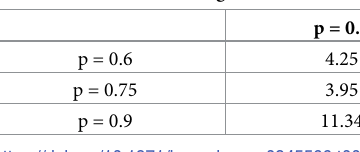
To confirm our findings, we further analyzed the data by considering the share of high- quality decisions of her high/low quality decisions (i.e., we interpreted our categorical variable as the percentage of each participant choosing high quality). Based on the data for each group of two participants in parts 1 and 2 of our experiment, we used the Jonckheere-Terpstra test [45, 46] to assess whether a trend in the data is apparent. Since we presume that effects needed some rounds to level off, we used the data from rounds 13–24 (part 1) and 37–48 (part 2) for this assessment. The result shows a trend with significance for part 1 (p < 0.10, n = 24, df = 3) and part 2 (p < 0.01, n = 24, df = 3). (When considering all rounds, the p-values amount to 0.105 for part 1 and 0.023 for part 2.) This indicates that the high-quality decisions as well as the high-quality collaboration in teams increase along with p. Table 3. Odds ratios among the four different